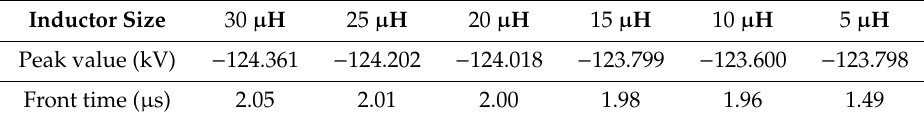
Table 2. E ff ects of di ff erent filter sizes on the overvoltage amplitude 125 kV applied impulse. Table 2. Effects of different filter sizes on the overvoltage amplitude 125 kV applied impulse.